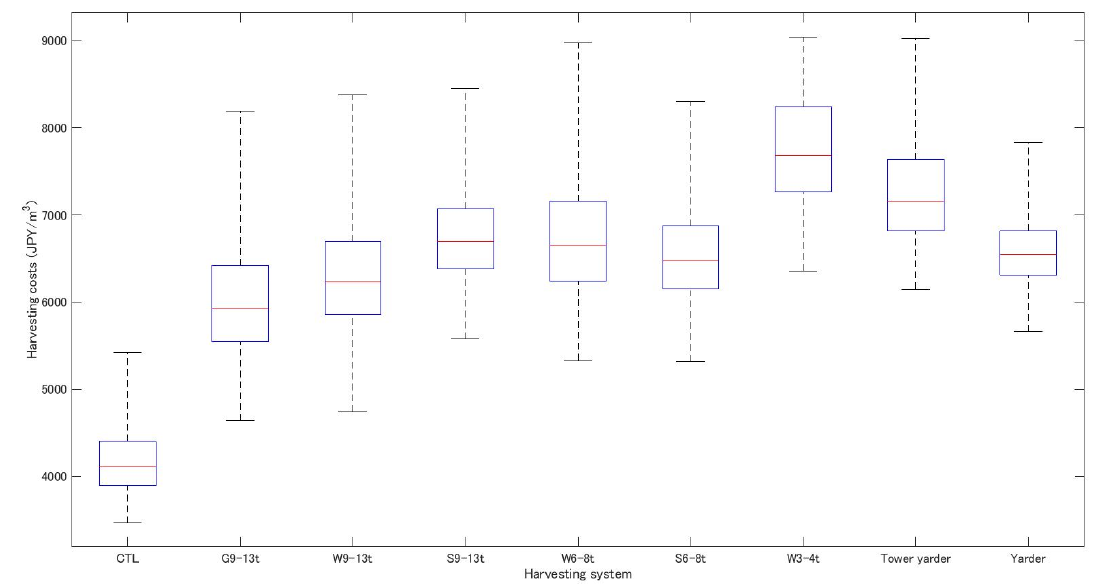
Figure 2. Harvesting costs according to harvesting systems.